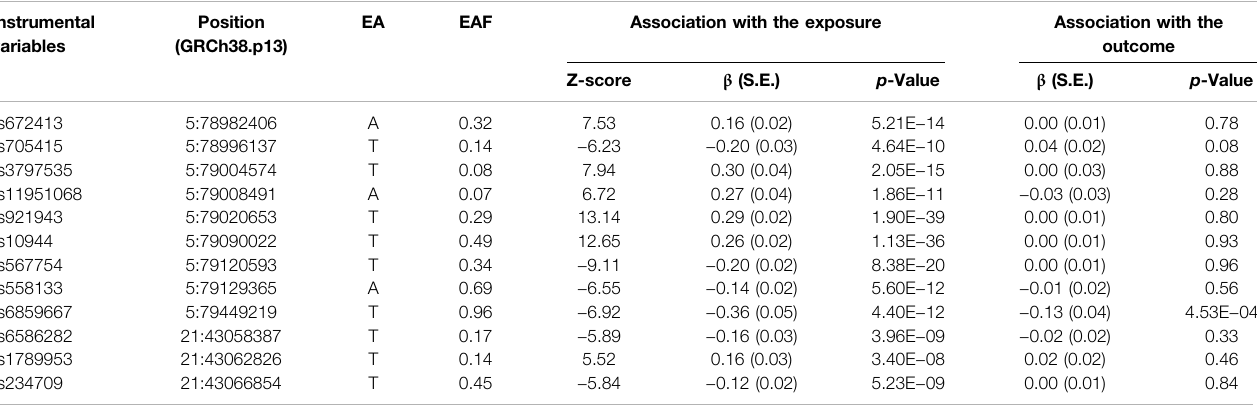
TABLE 2 | Characteristics of the instrumental variables used in two-sample Mendelian randomization (MR) analysis. Instrumental